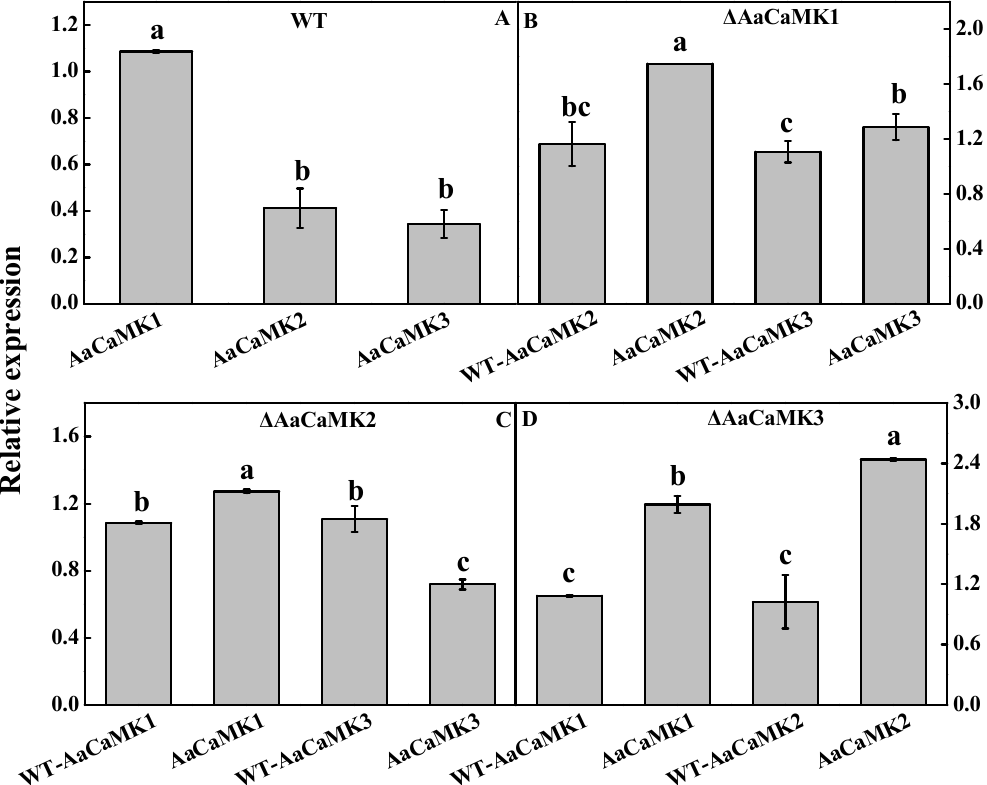
Figure 4. The transcription levels of AaCaMKs genes. The expression level of the AaCaMKs gene in WT strains was plotted as a control. ( A ) Expression levels of AaCaMK1 , AaCaMK2 and AaCaMK3 in WT. ( B ) Expression levels of AaCaMK2 and AaCaMK3 in ΔAaCaMK1 . ( C ) Expression levels of AaCaMK1 and AaCaMK3 in ΔAaCaMK2 . ( D ) Expression levels of AaCaMK1 and AaCaMK2 in ΔAaCaMK3 . Bars indicate standard error (±SE). Different letters indicate significant differences ( p < 0.05) .